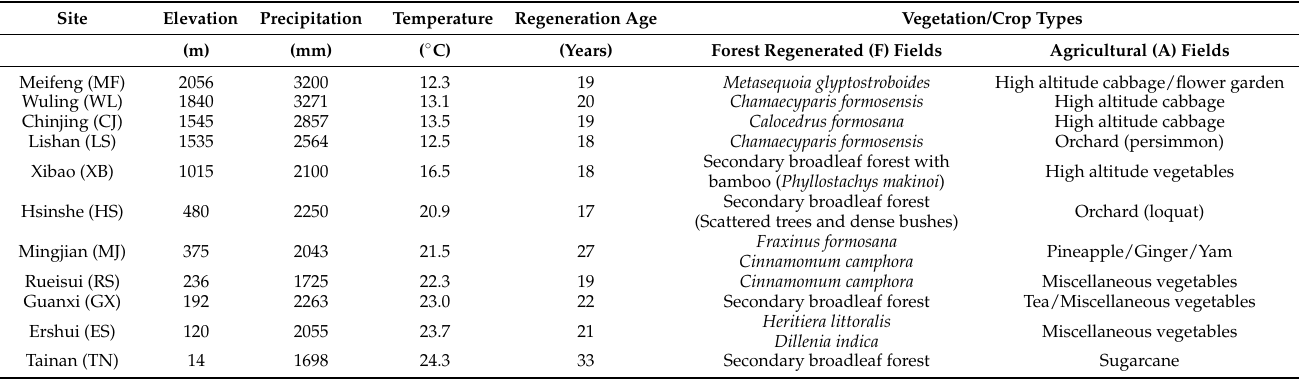
Figure 1. Locations of the study sites and their corresponding elevations. Table 1 presents the locations, climate characteristics, forest regeneration period (years), and vegetation/crop types of the selected study sites. The average forest regeneration period for the 11 sites was 21.1 years (range: 17–33 years). The mean annual temperature at the study sites ranged from 12.3 ◦ C to 24.3 ◦ C and decreased with elevation. The mean annual precipitation increased slightly from 1700 to 3200 mm with elevation due to the orographic effect. On the basis of elevation related to climate and agricultural background, the sites can be roughly classified as the low-elevation fields with altitudes below 1000 m above sea level and the middle-elevation fields with altitudes above 1000 m. Table 1. Site and climate characteristics of the study sites with paired forest regenerated (F) and adjacent agricultural (A) fields in Taiwan.